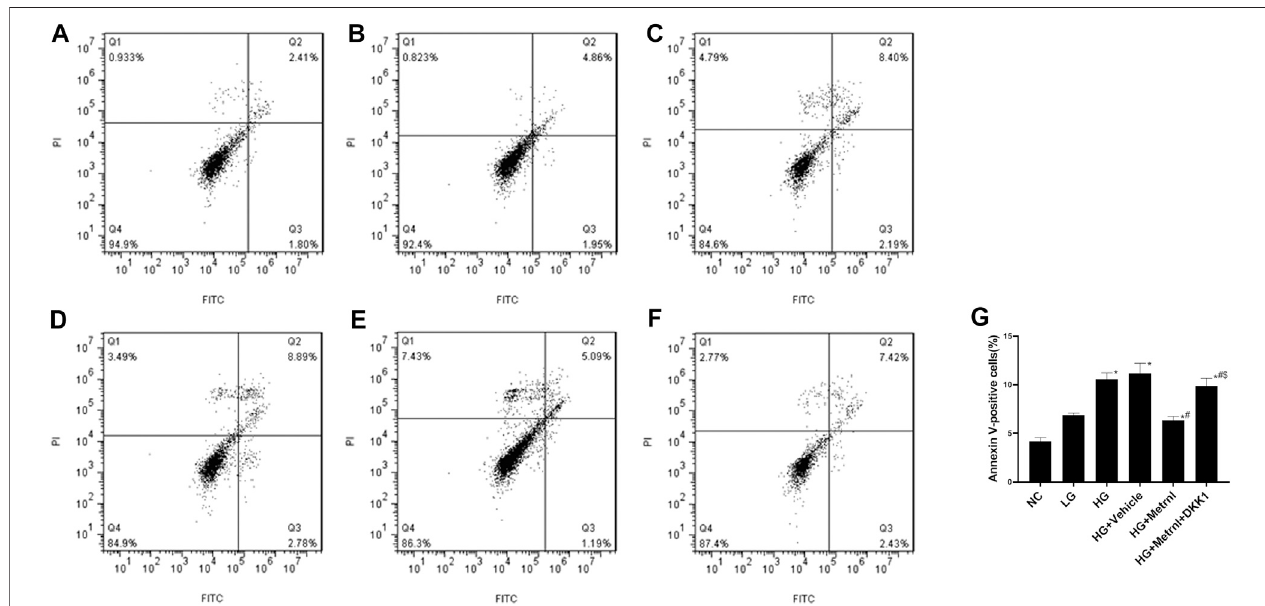
FIGURE3| β cellapoptosisbetweendifferentgroupsevaluatedusing fl owcytometryanalysis. (A) normalcontrol(NC); (B) lowglucose(LG); (C) highglucose(HG); (D) HG + Vehicle; (E) HG + Metrnl; (F) HG + Metrnl + DKK1. (G) quantitative analysis of different